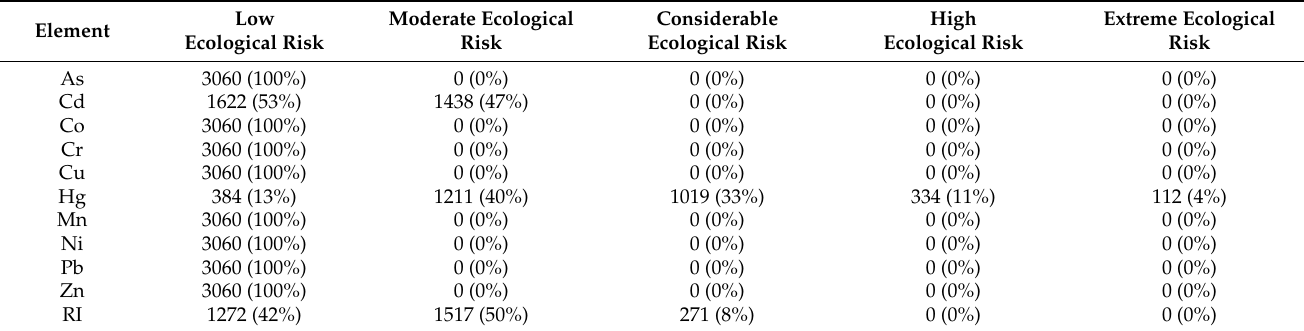
Table 7. The result of the percentage of E r and RI grades.